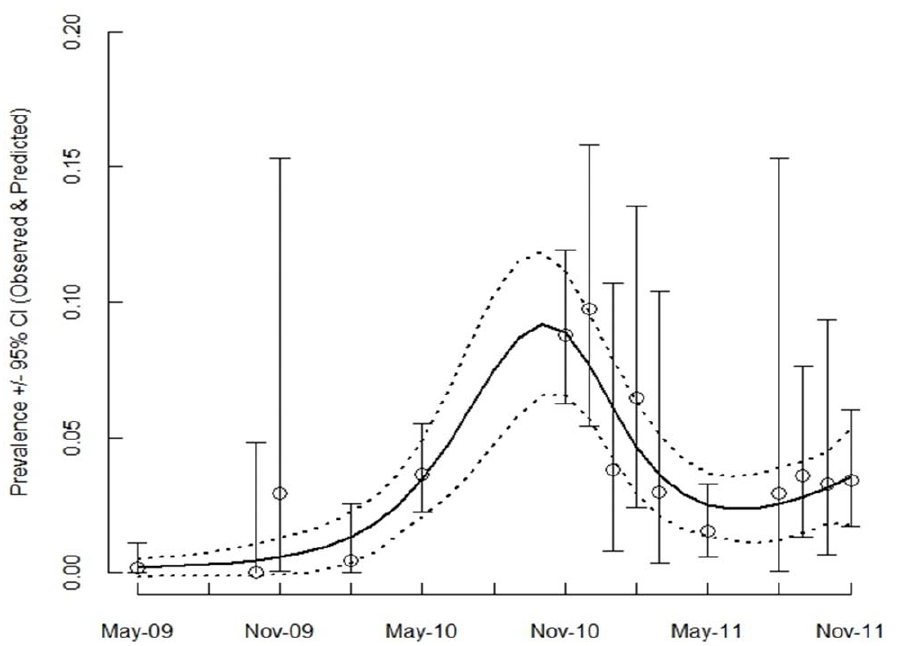
Figure 1. Observed prevalence of pox in great tits (with 95% exact binomial confidence intervals). The solid line represents the fit of the predicted values from the final generalised additive model (see Table 5). Dotted lines show 95% CI of the predicted prevalence estimates.